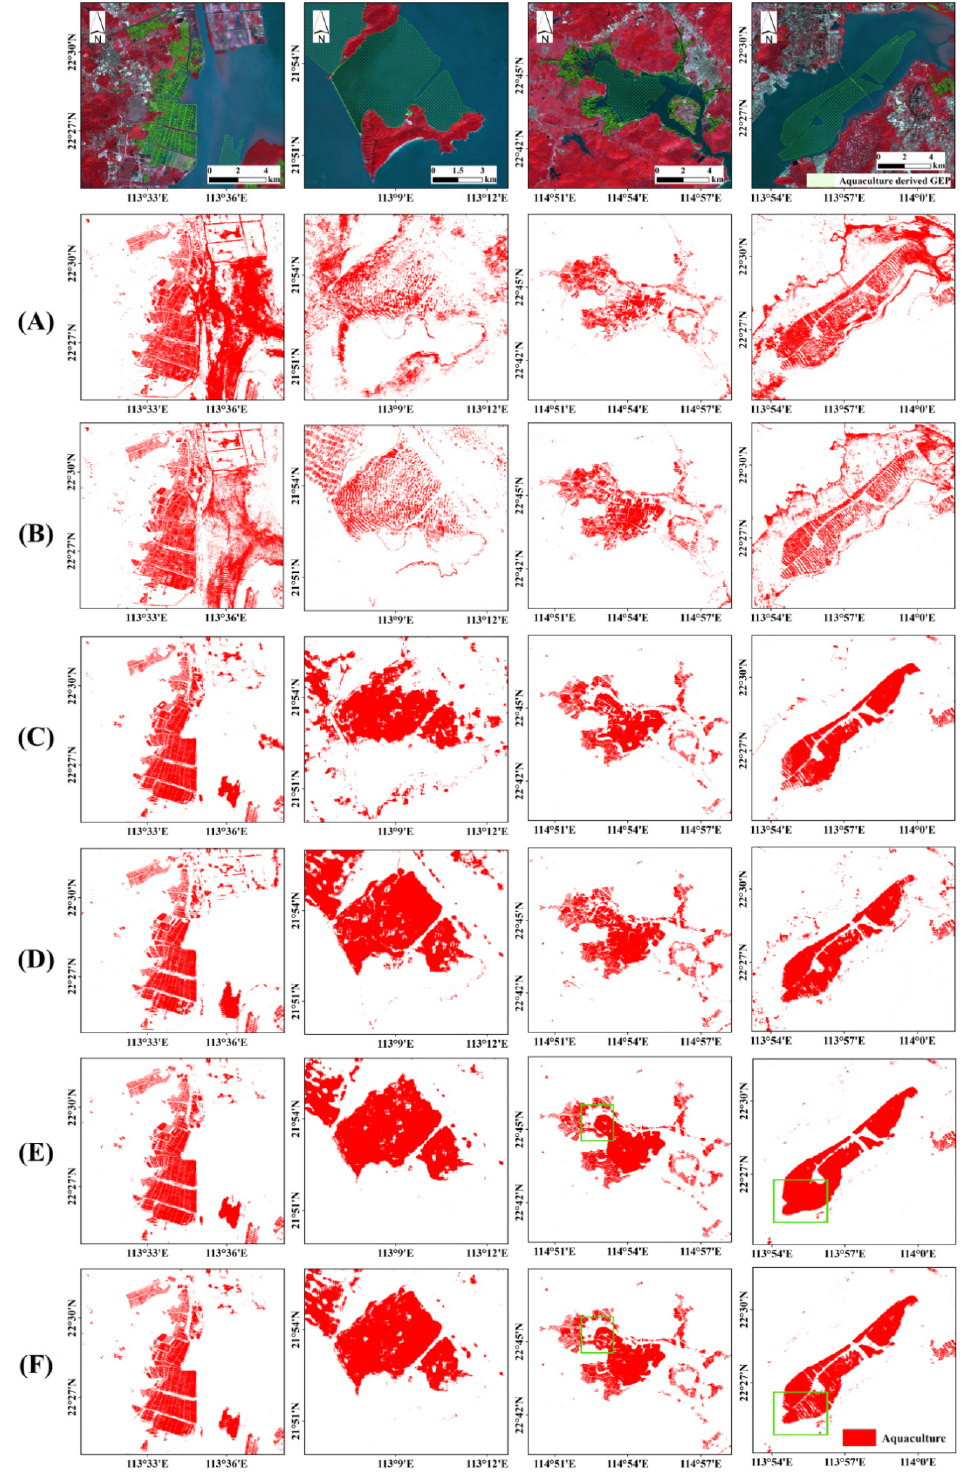
Figure 7. Aquaculture maps obtained using different feature combinations. The first-row present images and reference aquaculture areas at four typical sites, and the results of combinations ( A – F ) are presented in the second to seventh rows. The details of feature combinations are presented in Table 3.